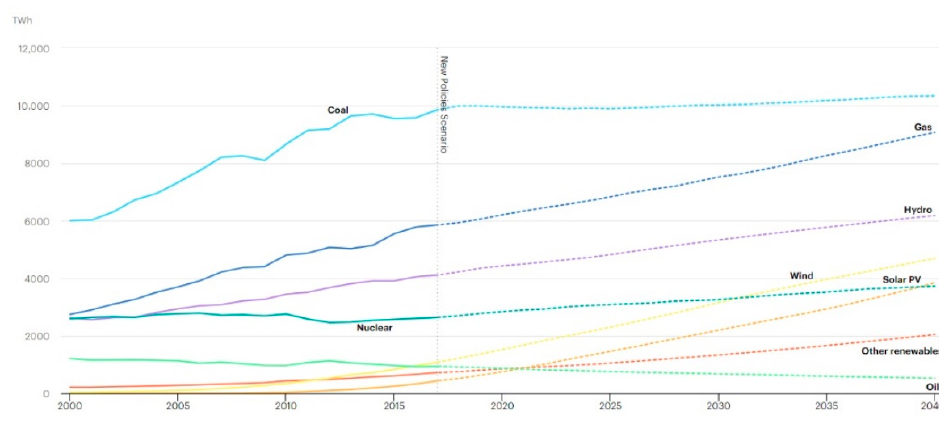
Figure 1. Forecasts regarding coal-fired generation [3].